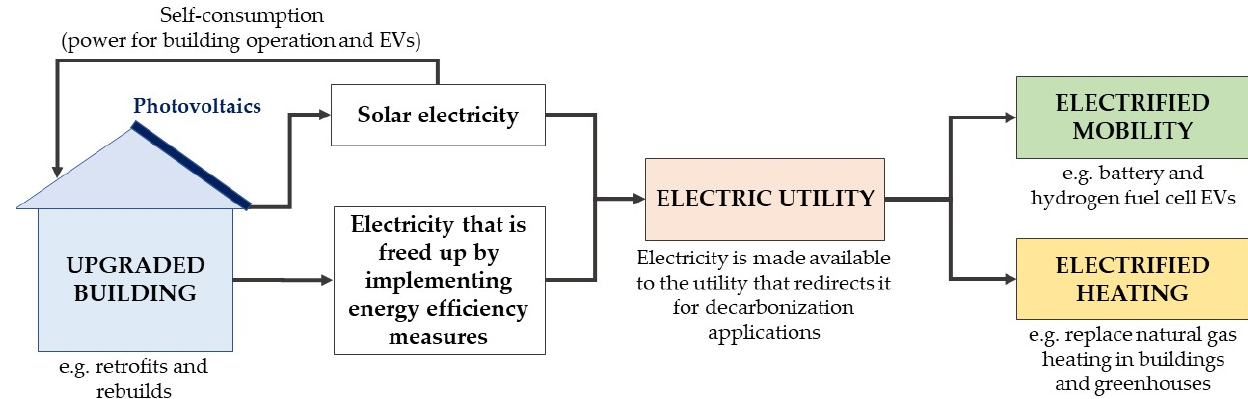
Figure 1. Diagram showing how building energy upgrades can make electricity available to the utility who redirects it for decarbonization applications and for the building itself (self-consumption).